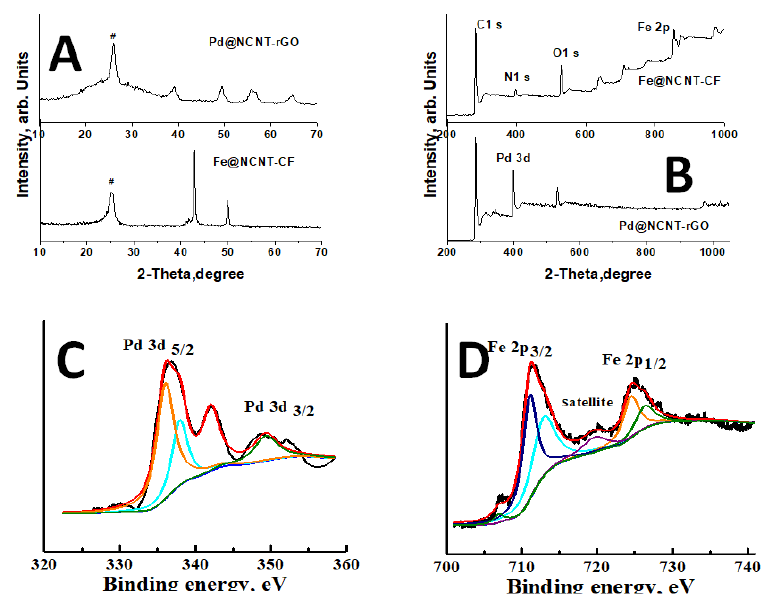
Figure 2. ( A ) XRD and ( B ) XPS plots of Pd@NCNT-rGO and Fe@NCNT-CF, respectively. Deconvo- luted ( C ) Pd 3d and ( D ) Fe 2p spectra. luted ( C ) Pd 3d and ( D ) Fe 2p